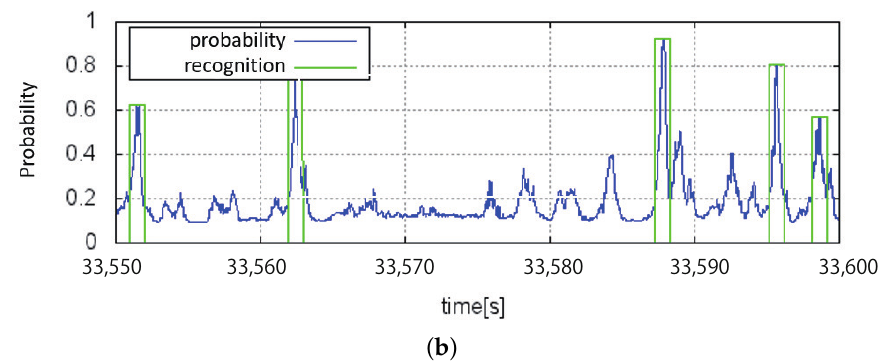
Figure 9. Action recognition output. ( a ) Acceleration sequences and ground truth of harvesting action indicated by red lines; ( b ) probability derived from Random Forest indicated by blue line and recognition results of harvesting action indicated by green